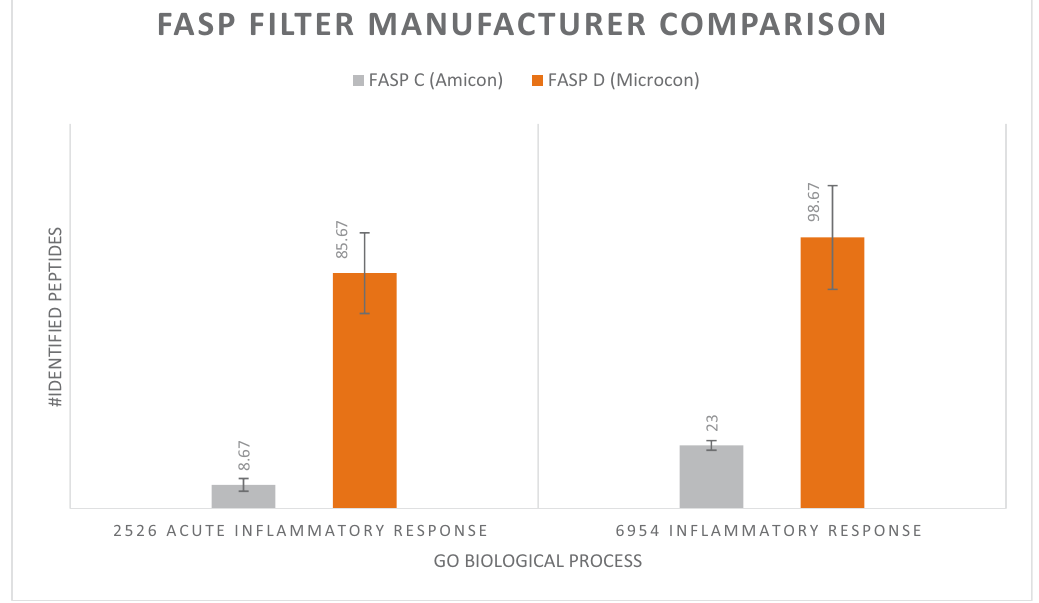
Figure 4: Bar graph depicting the arithmetic mean and standard deviation ( error bars ) of the number of identi fi ed proteins/peptides involved in GO biological process − in fl ammatory response. Each sample was measured in biological triplicate. An identical FASP sample preparation protocol was used for both manufacturers of MWCO 30 kDa fi lters ( Amicon and Microcon )